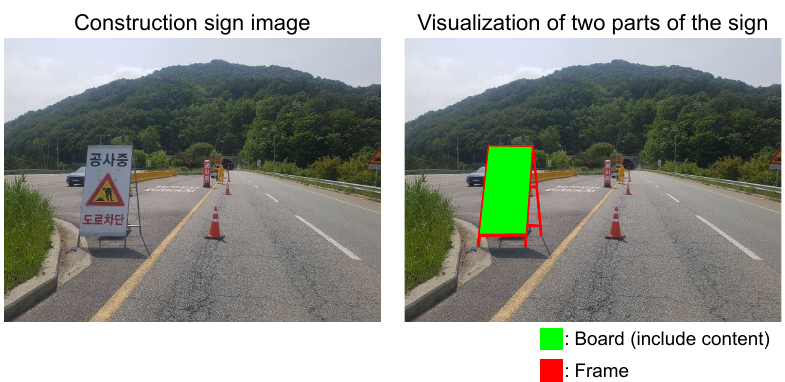
Figure 5. Visualization of the two parts of the construction sign. In the first column, we show a construction sign image. In the second column, we denote the board and frame regions with green and red,